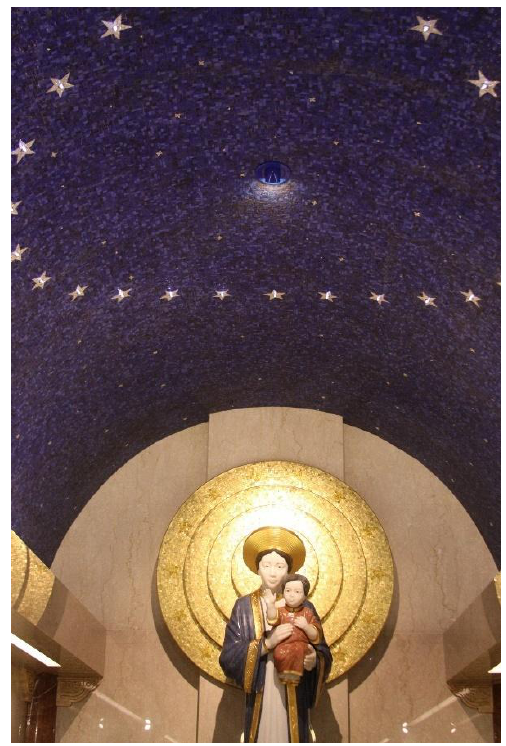
Figure 3. The Our Lady of Lavang National Shrine, decorated with stars representing the global dispersion of Vietnamese Catholics (the Basilica of the National Shrine of the Immaculate Conception, Washington, D.C.).